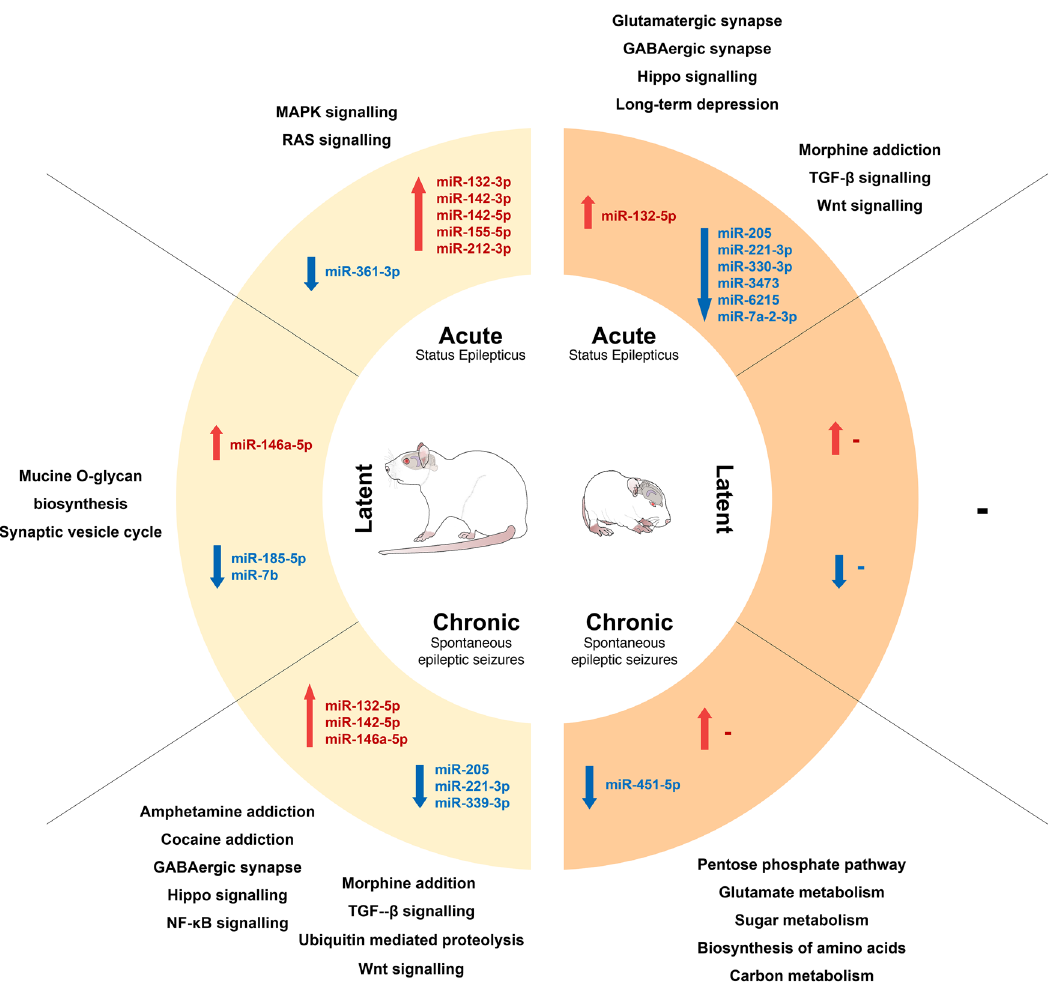
Figure 4. miRNAs with altered expression in adult and infantile-onset epilepsy-summary diagram. The diagram summarizes the occurrence of dysregulated miRNAs after status epilepticus (SE) induced in adulthood (left; adult rat) and infancy (right; rat pup). The inner parts specify the stage of epileptogenesis with a short description of seizure occurrence. The middle parts contain the lists of dysregulated miRNAs in the respective stages. Upregulated miRNAs are displayed in red, while downregulated miRNA after SE are shown in blue. The outer parts list the predicted pathways affected by dysregulated miRNAs in the given